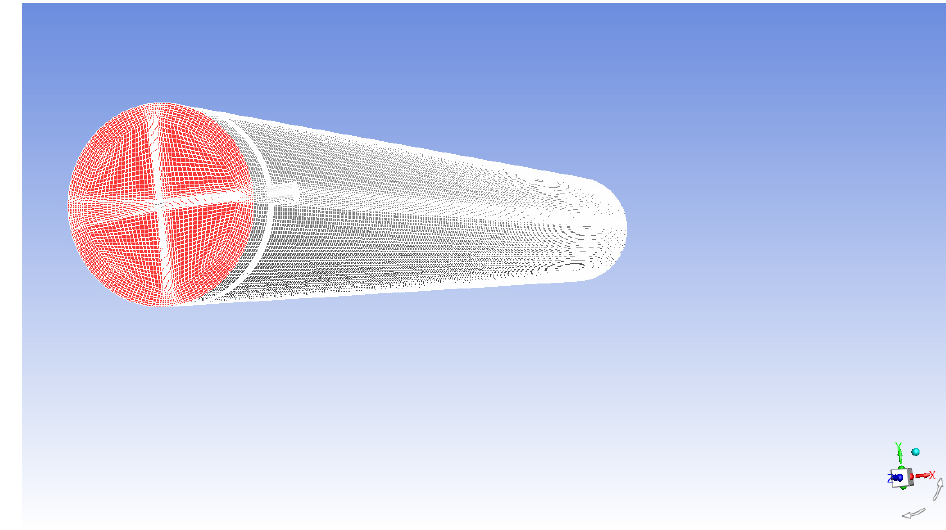
Figure 2. Membrane mesh